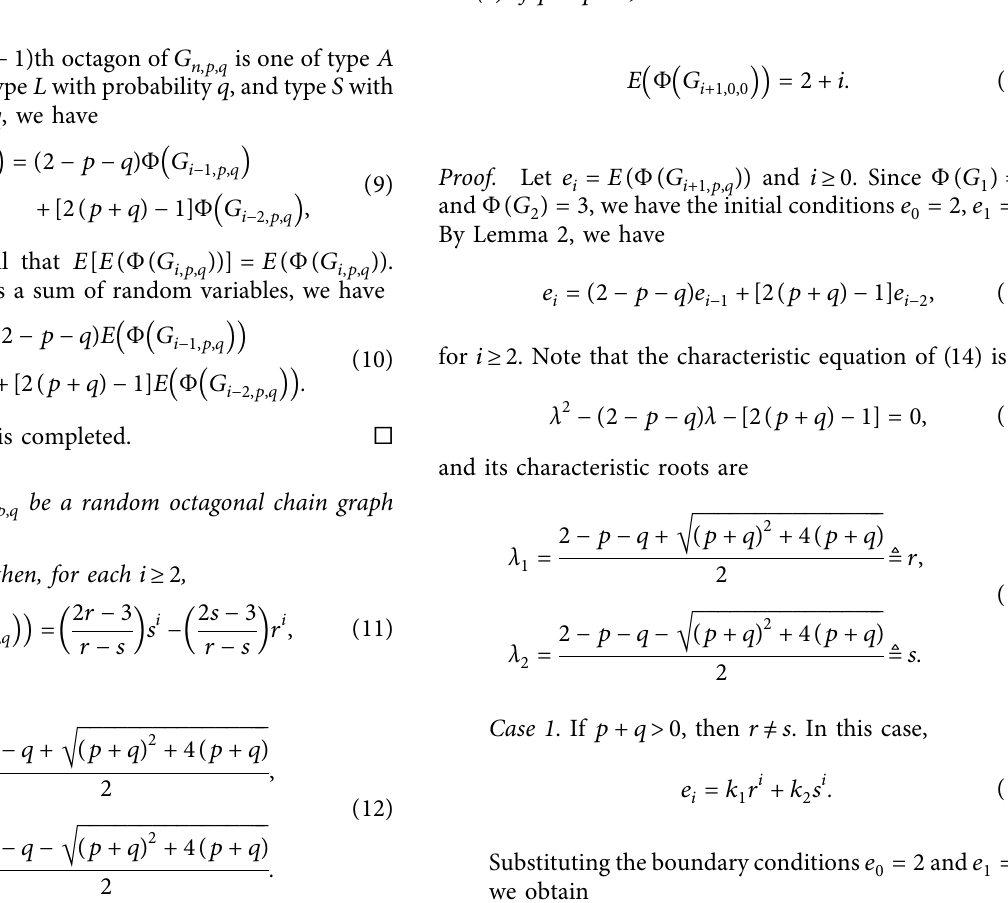
G − u − v . (c) G i i . (b)